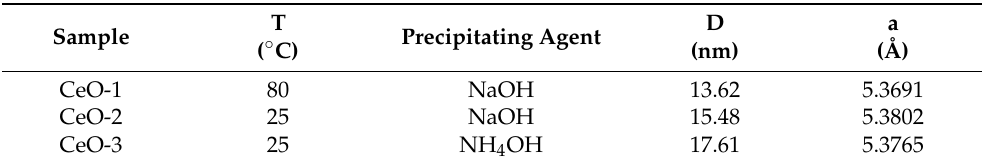
Table 1. XRD parameters of cerium oxide